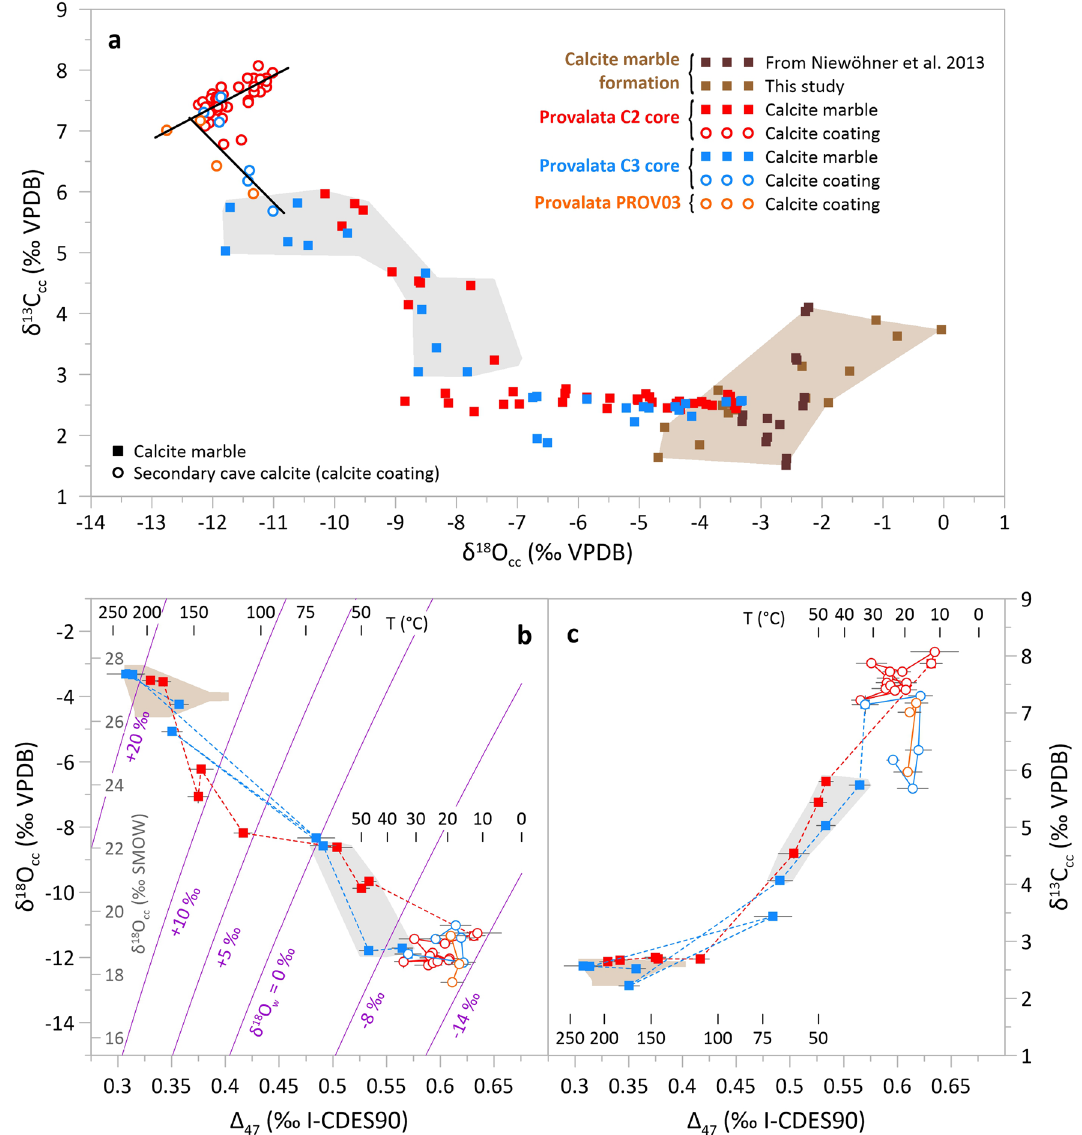
Figure 2. Conventional and clumped stable isotope composition of the studied carbonate samples. ( a ) Conventional stable isotope δ 18 O cc − δ 13 C cc plot. Black lines indicate the two trends of covariation of δ 18 O cc and δ 13 C cc values from Provalata Cave calcite coatings. ( b ) Clumped isotope composition (Δ 47 ) vs δ 18 O cc . Equilibrium curves based on the equation of Daëron et al. 31 for a given water stable isotope composition (δ 18 O w ) are shown in purple. ( c ) Clumped isotope composition vs δ 13 C cc . Apparent clumped isotope-based temperatures are also indicated in ( b ) and ( c ). Shaded brown and grey areas show range of values for the unaltered calcite marble and the narrow white rim,